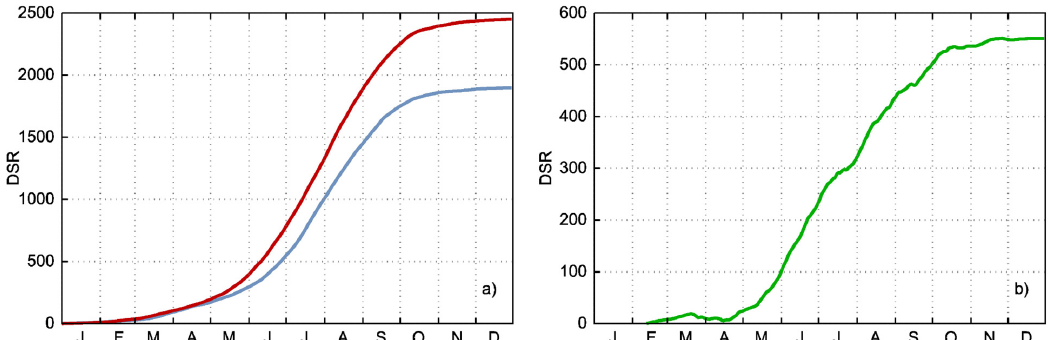
Figure 7. ( a ) Daily mean cumulative DSR values in the first (1980–1999, blue curve) and second halves (2000–2018, red curve) of the study period. The DSR is cumulated daily from 1 January to 31 December each year. ( b ) Daily difference between the two periods’ DSR mean values (1980–1999 and 2000–2018) with modified scale on the Y-axis.